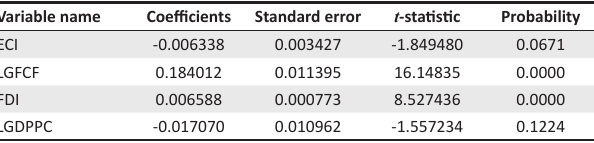
TABLE 1: Panel autoregressive distribution lag long-run